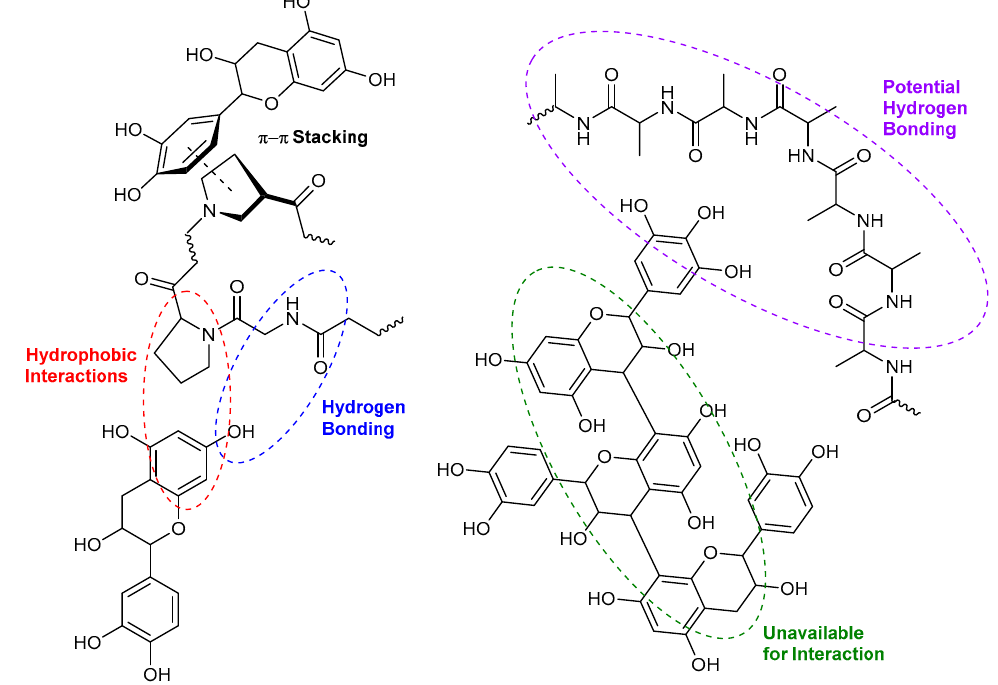
Figure 2. The possible hydrophobic interactions and hydrogen bondings between flavanol monomer or tannins with a protein.